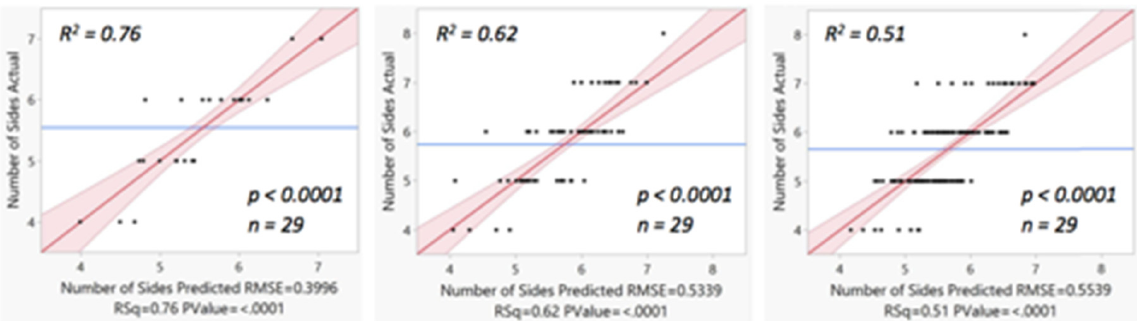
Figure 23. Plots of observed versus expected number of sides of the convex polygons in these Voronoi tessellations of Troboleum casteneum embryos described above. The three multiple linear regression graphs of expected versus predicted are all significant and as shown in Table 4 are much better than angle of the other four models that were tested.